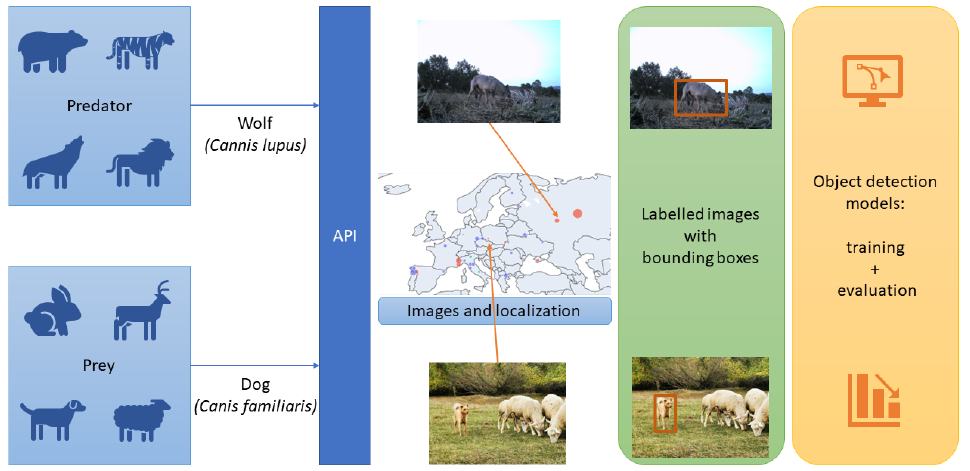
Figure 2. Pipeline of the vision module. First, images and their location are acquired using an API; then, images are labelled to train object detection models.